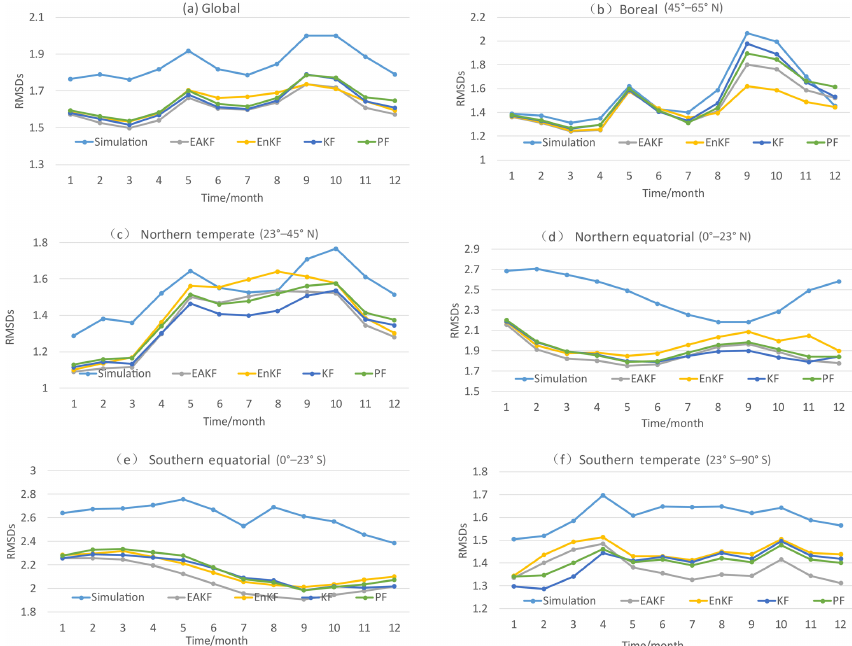
Figure 4. RMSDs of ensemble means of simulation and assimilation versus GEOV2 LAI for (a) global, (b) boreal (45–65 ◦ N), (c) northern temperate (23–45 ◦ N), (d) northern equatorial (0–23 ◦ N), (e) southern equatorial (0–23 ◦ S), and (f) southern temperate (23–90 ◦ S).